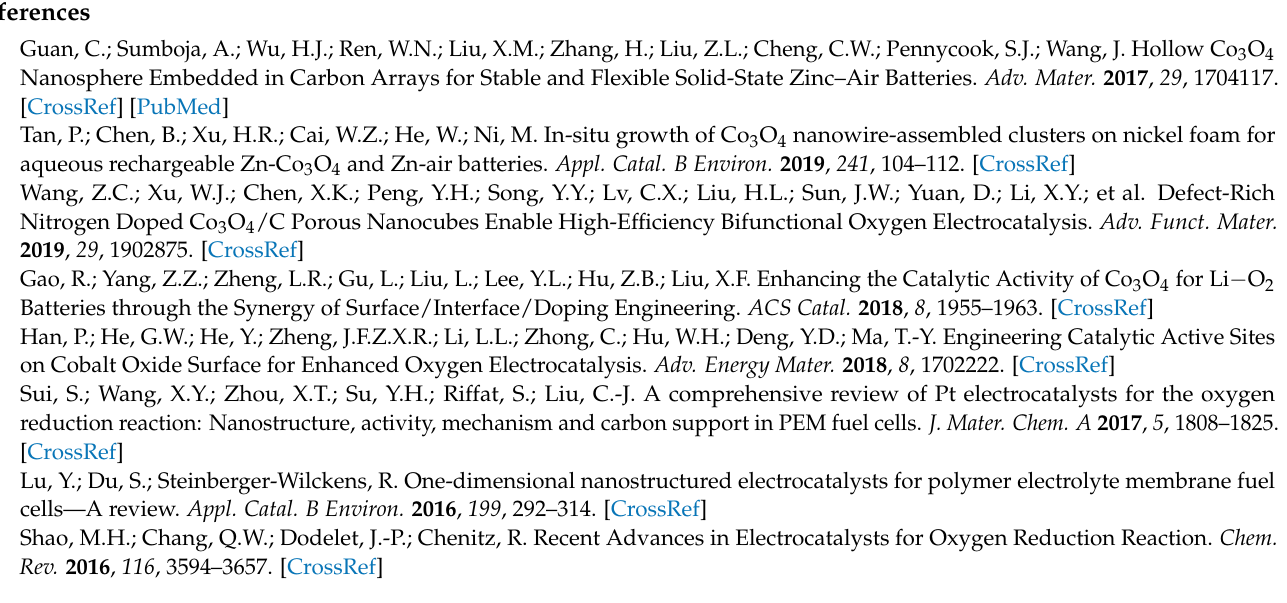
ment. Section S1: Experimental section, structural characterization of CoPc and contrast samples, N 2 adsorption–desorption isotherms of samples, and stability of sample after electrochemical